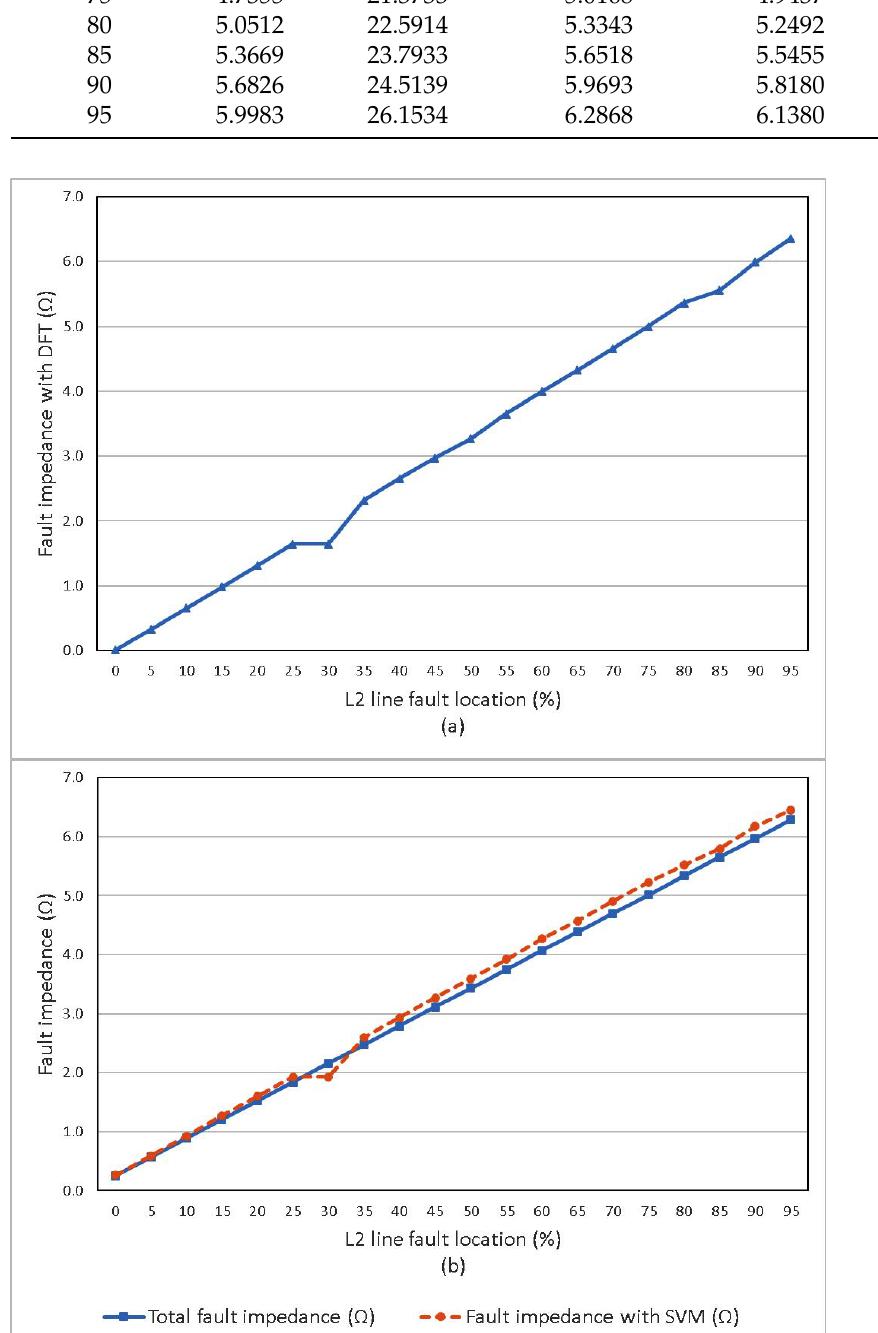
Figure 14. Three-phase faults. ( a ) Fault impedance with DFT-fault location. ( b ) Total fault impedance and fault impedance with SVM-fault